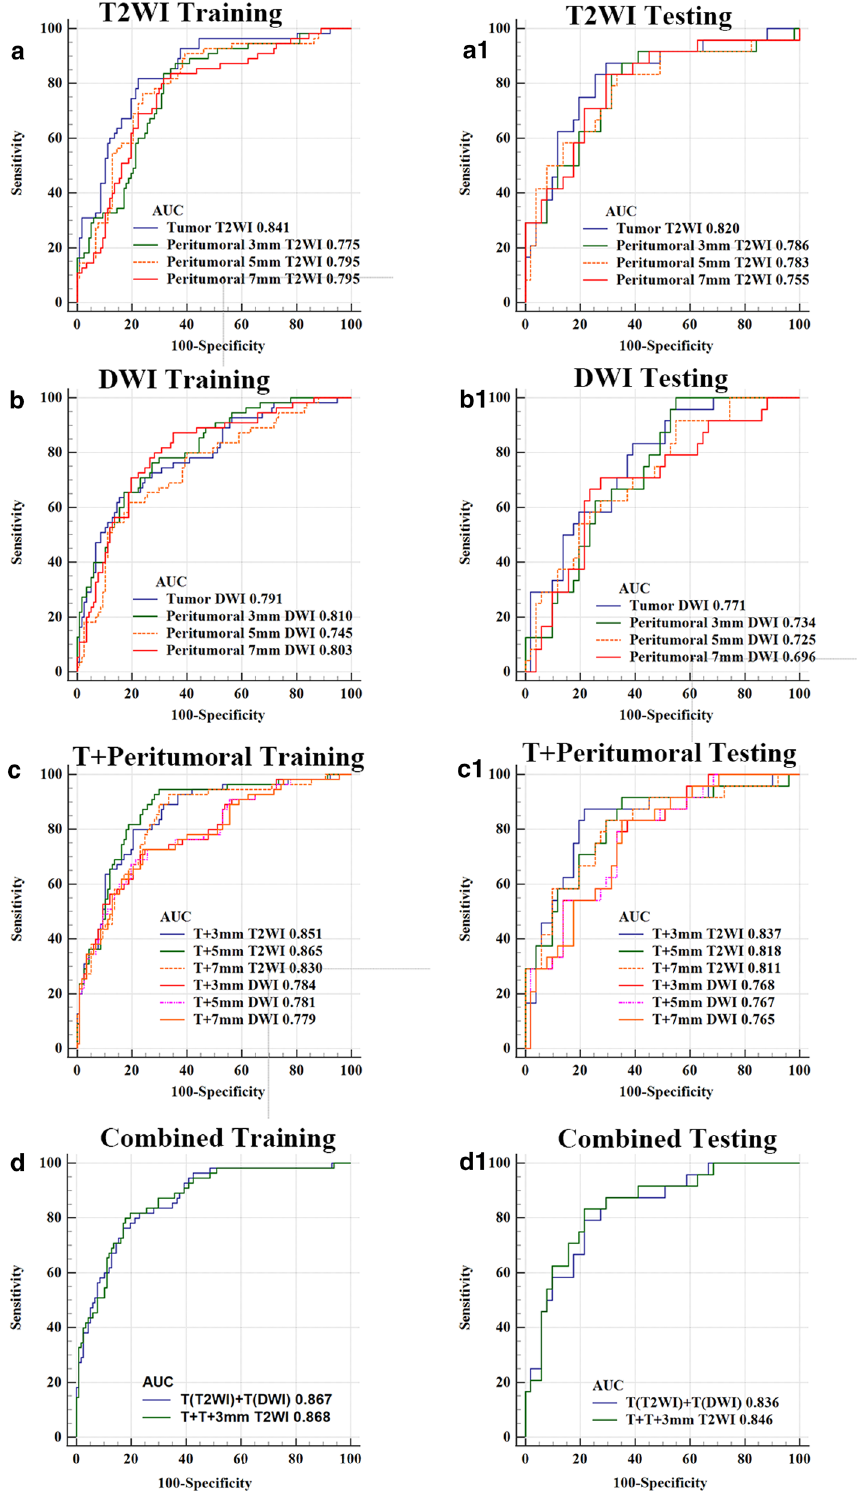
Fig. 3 ROC curves of intra- and peritumoral regions with (3, 5, 7 mm) expansion dimension, intra-tumoral region plus peritumoral regions with (3, 5, 7 mm) expansion dimension on T2WI and DWI, combining intra-tumor regions in T2WI and DWI, combined radiomics signature from tumors in the T2WI, DWI and peritumoral 3 mm expansion in T2WI in the ( a-d ) training and ( a1-d1 ) testing sets,